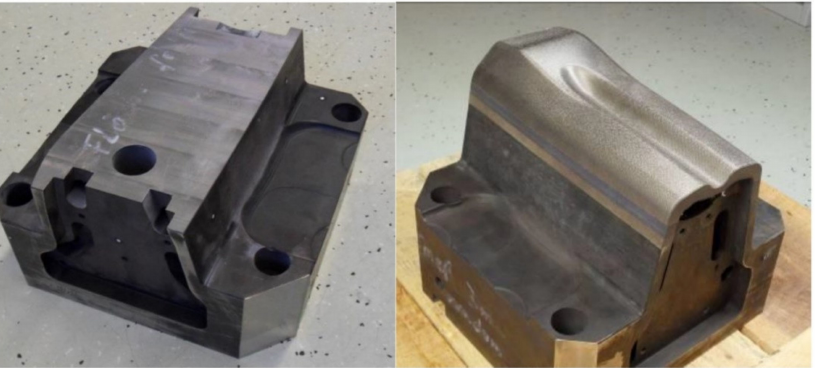
Figure 16. Tool insert for hot stamping made by the so-called hybrid tooling. The tool base was made by conventional milling of a conventionally made solid block ( left ). The functional structure including the optimized cooling channel was made by L-PBF in DIN 1.2709 over this tool base ( right ). The figure ( right ) shows the hybrid tool ready for final machining [133].